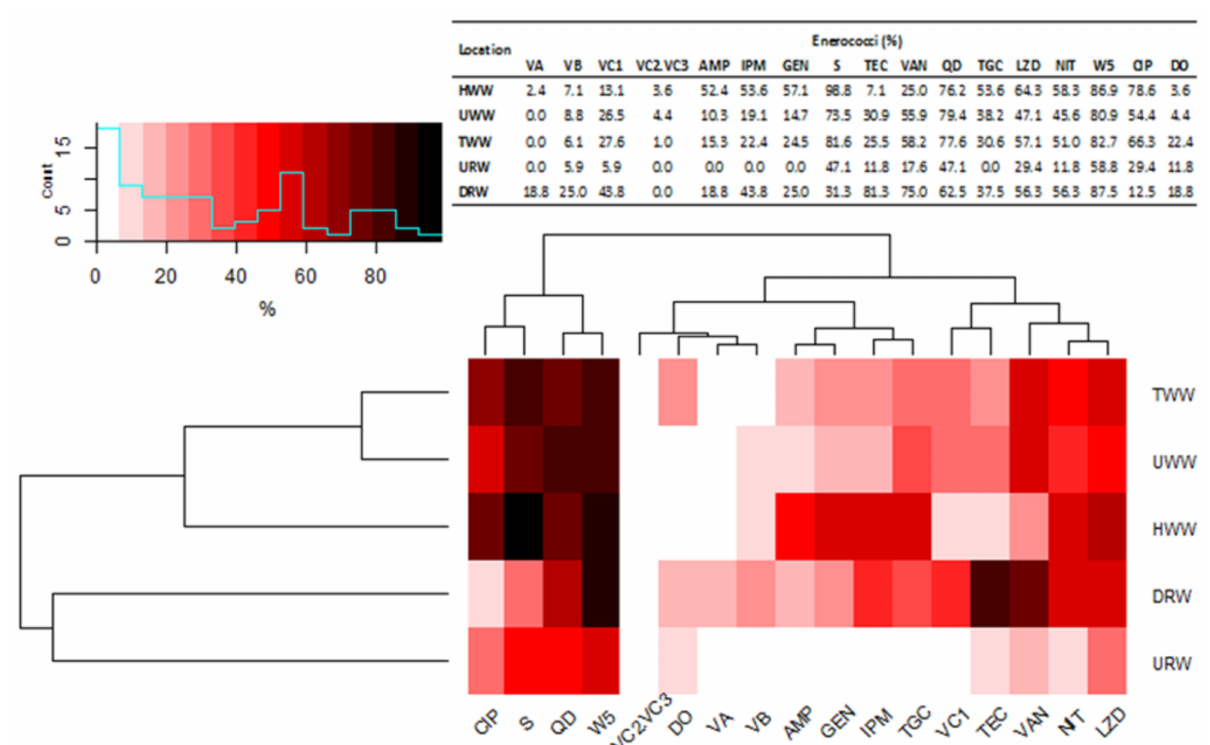
Figure 2. Heatmap with percentage content of studied multidrug resistant enterococcus among wastewater and river water (HWW—hospital wastewater; UWW—untreated wastewater; TWW—treated wastewater URW—upstream river water; DRW—downstream